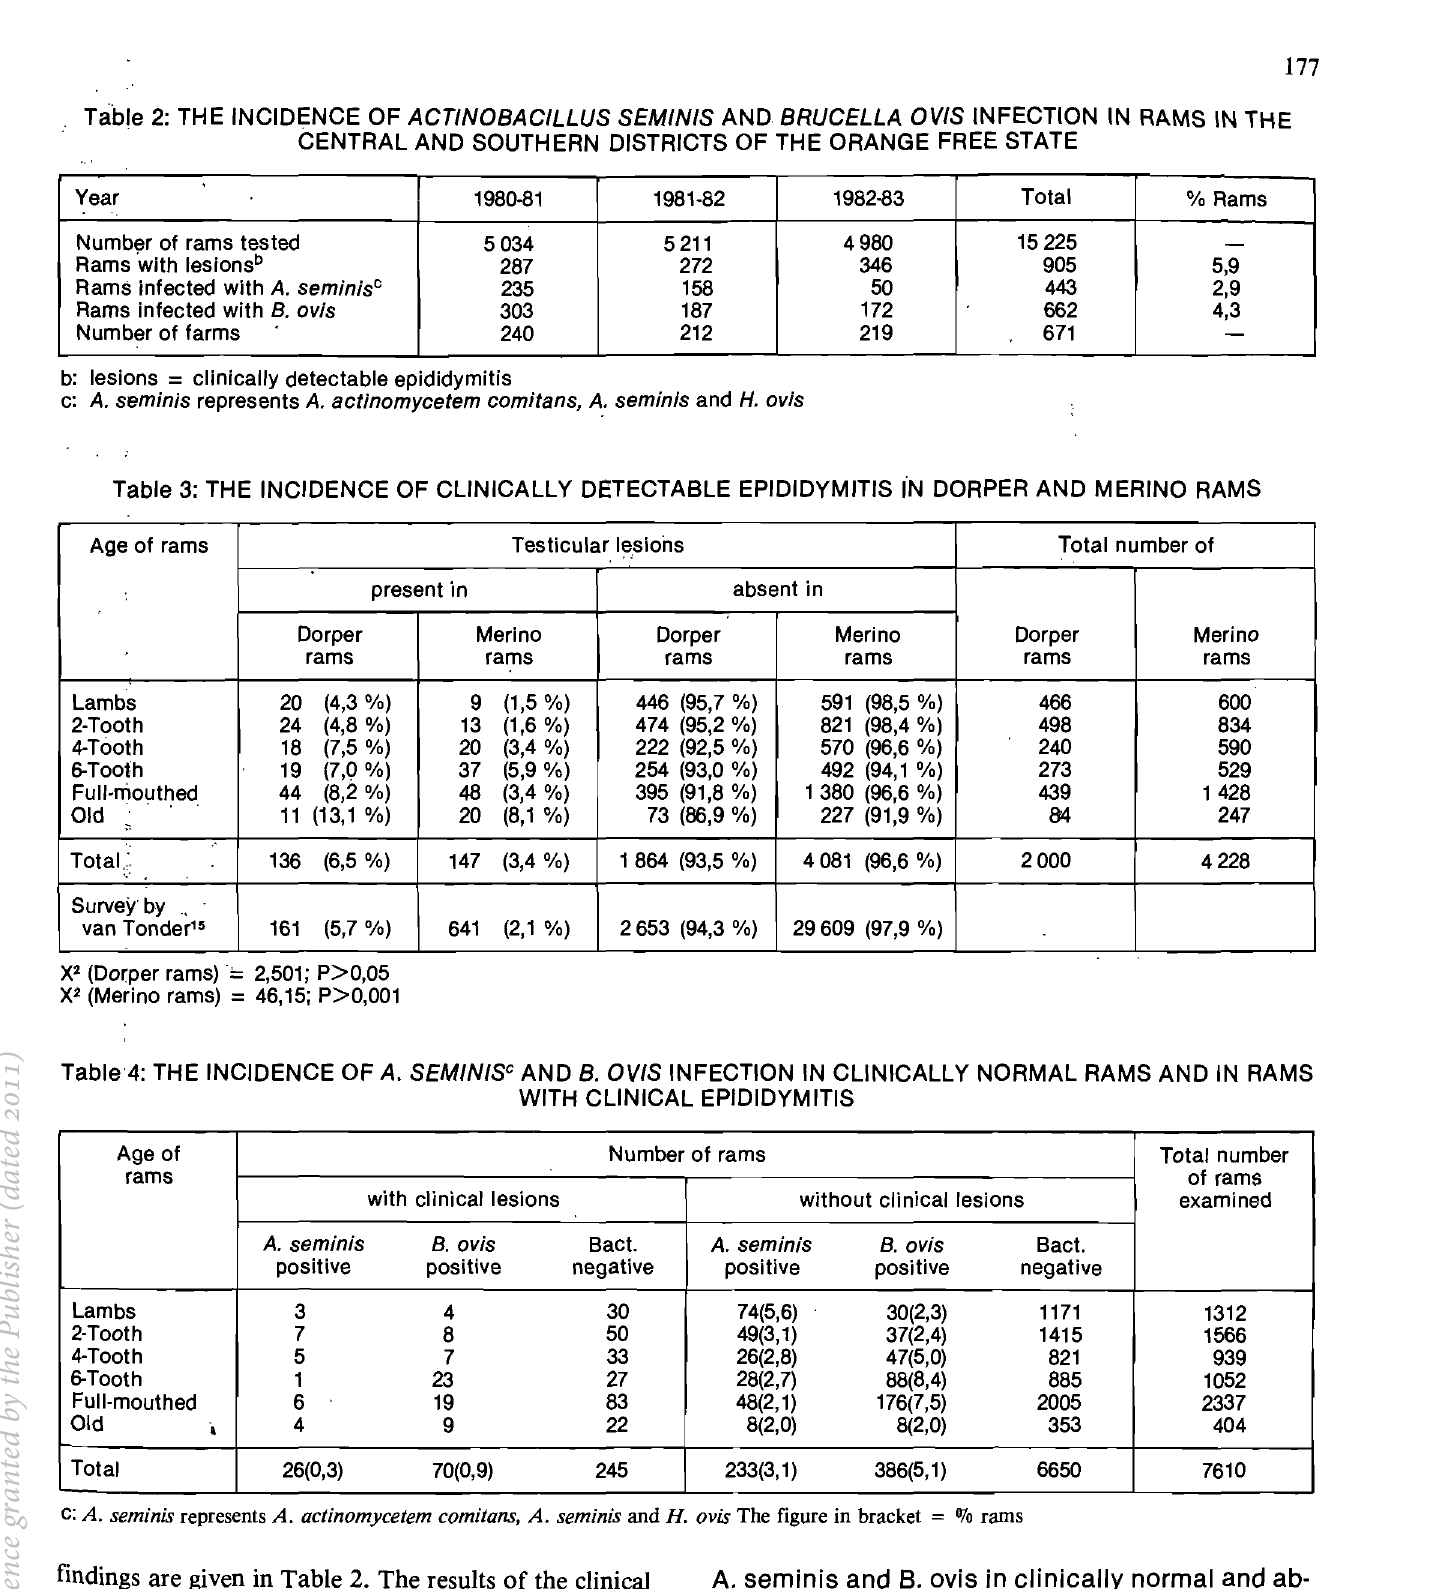
Table 3: THE INCIDENCE OF CLINICALLY DETECTABLE EPIDIDYMJTJS IN DORPER AND MERINO RAMS Age of rams